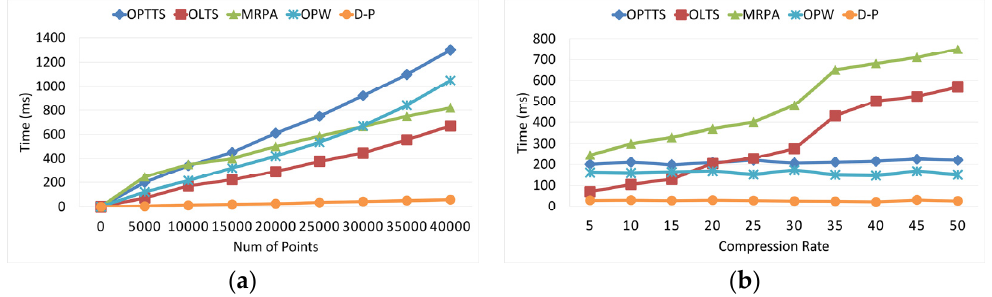
Figure 16. ( a ) Time cost of different number of points. ( b ) Time cost of different compression